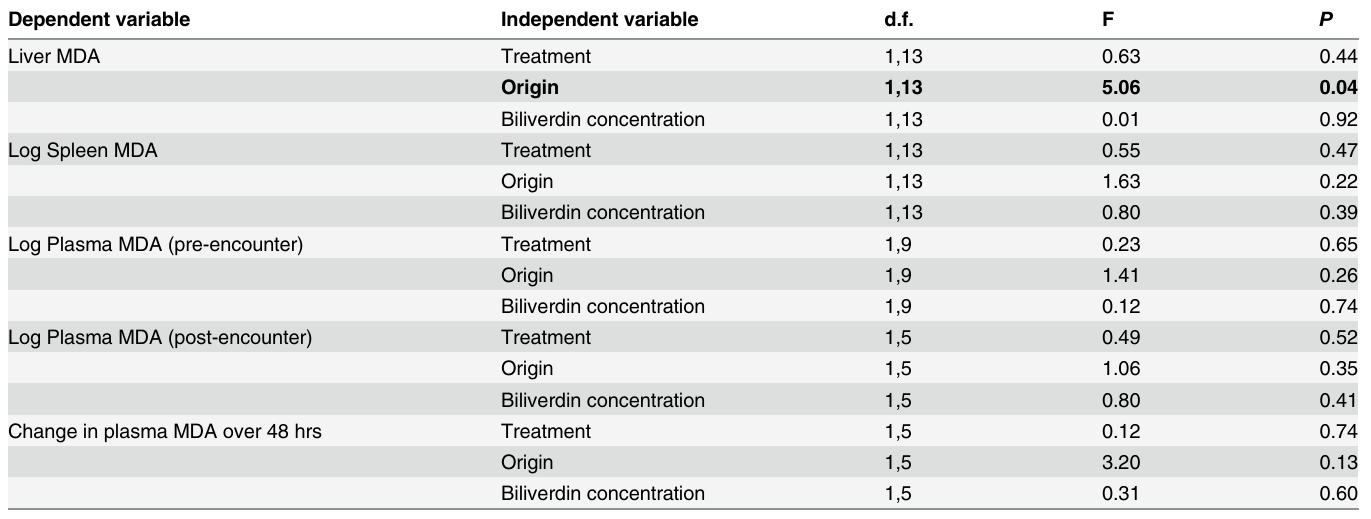
Table 2. Oxidative damage in multiple tissues was not affected by treatment when biliverdin concentration in the bile was included as a covariate.